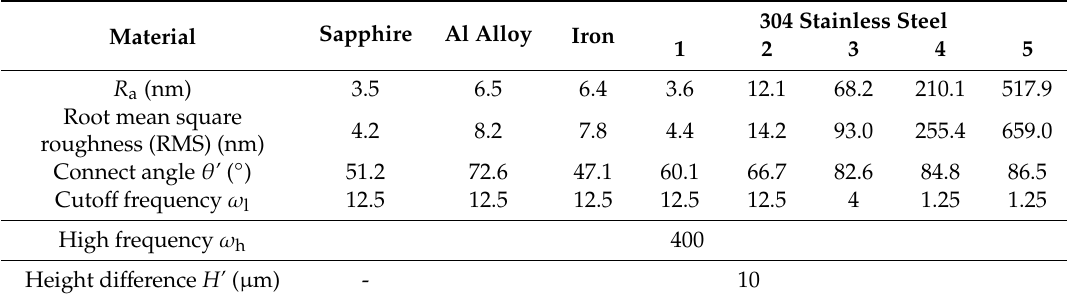
Table 1. Surface parameters of di ff erent materials.